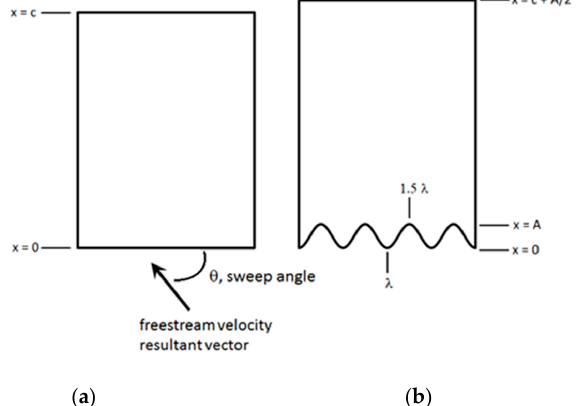
Figure 1. Flat plate coordinate system geometry. The flat plate is shown with straight leading edge, and typical streamline and crossflow velocity profiles are shown on the rotated coordinates.